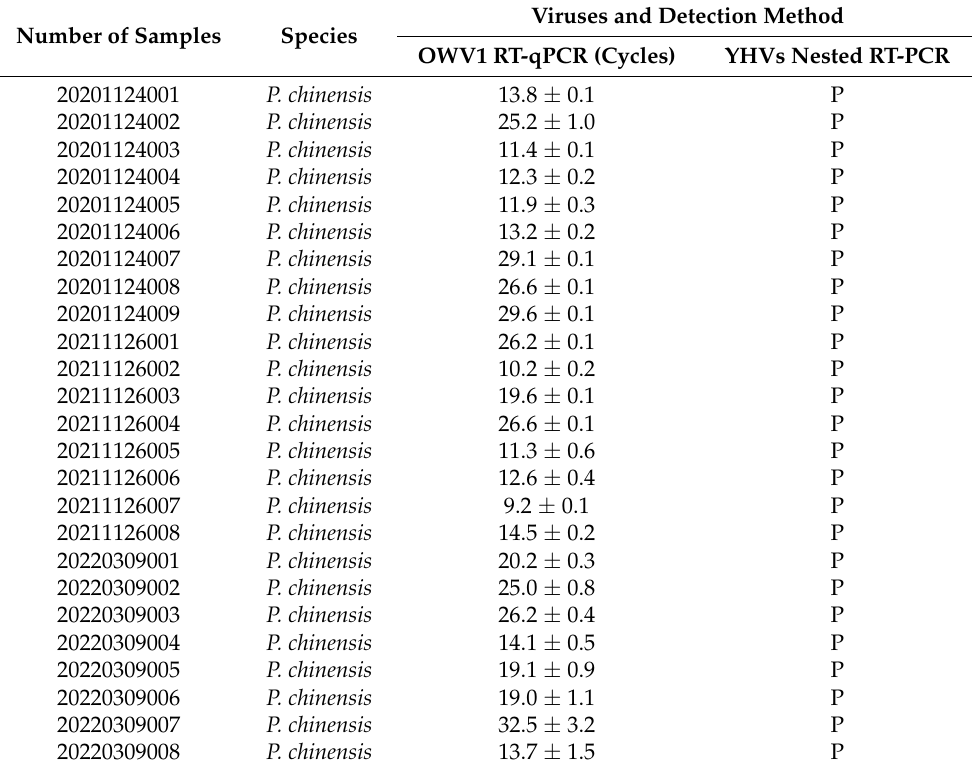
Table 3. Oriental wenrivirus 1 (OWV1) and yellow head complex viruses (YHVs) testing results of each